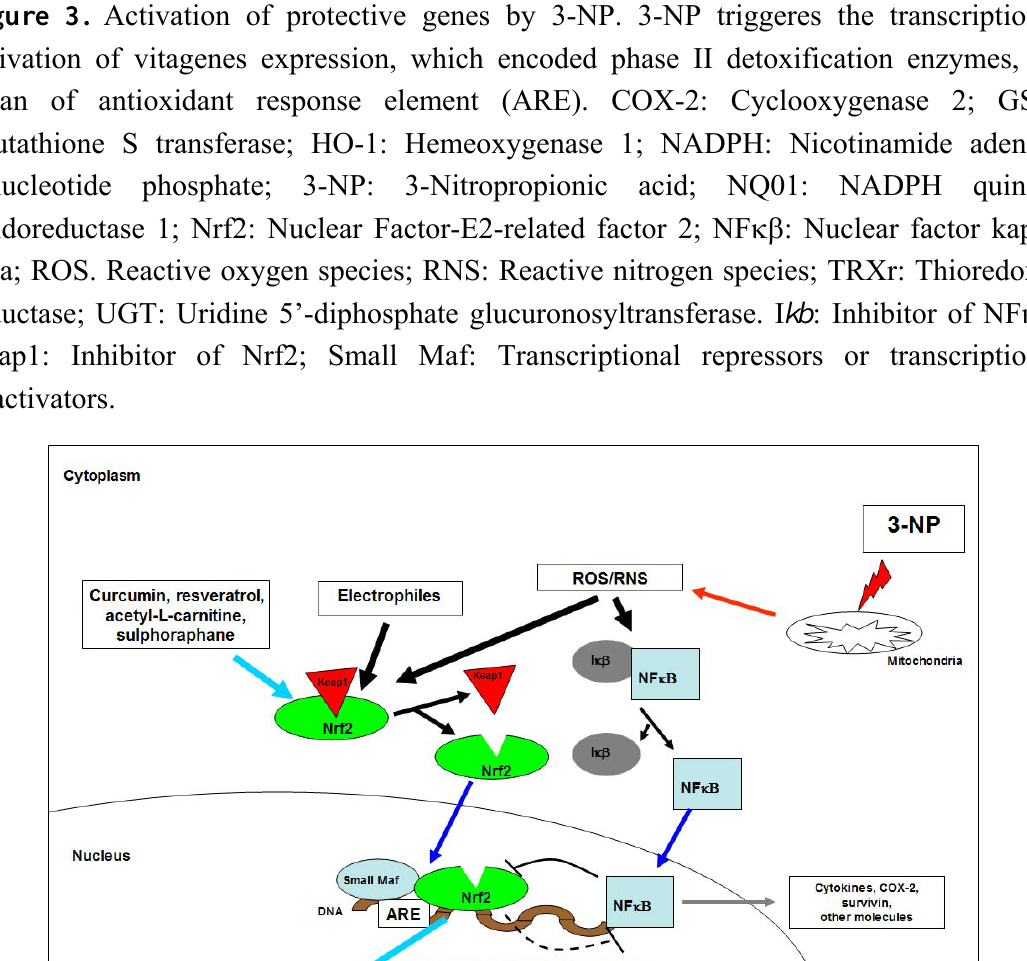
Figure 3. Activation of protective genes by 3-NP. 3-NP triggeres the transcriptional activation of vitagenes expression, which encoded phase II detoxification enzymes, by mean of antioxidant response element (ARE). COX-2: Cyclooxygenase 2;